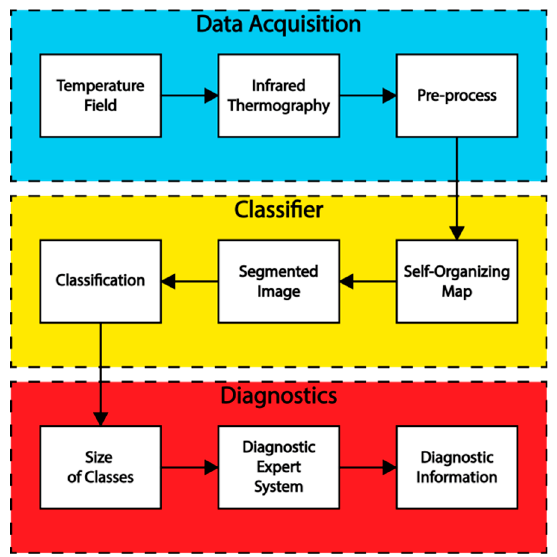
Figure 2. The conceptual design of the diagnostic system.